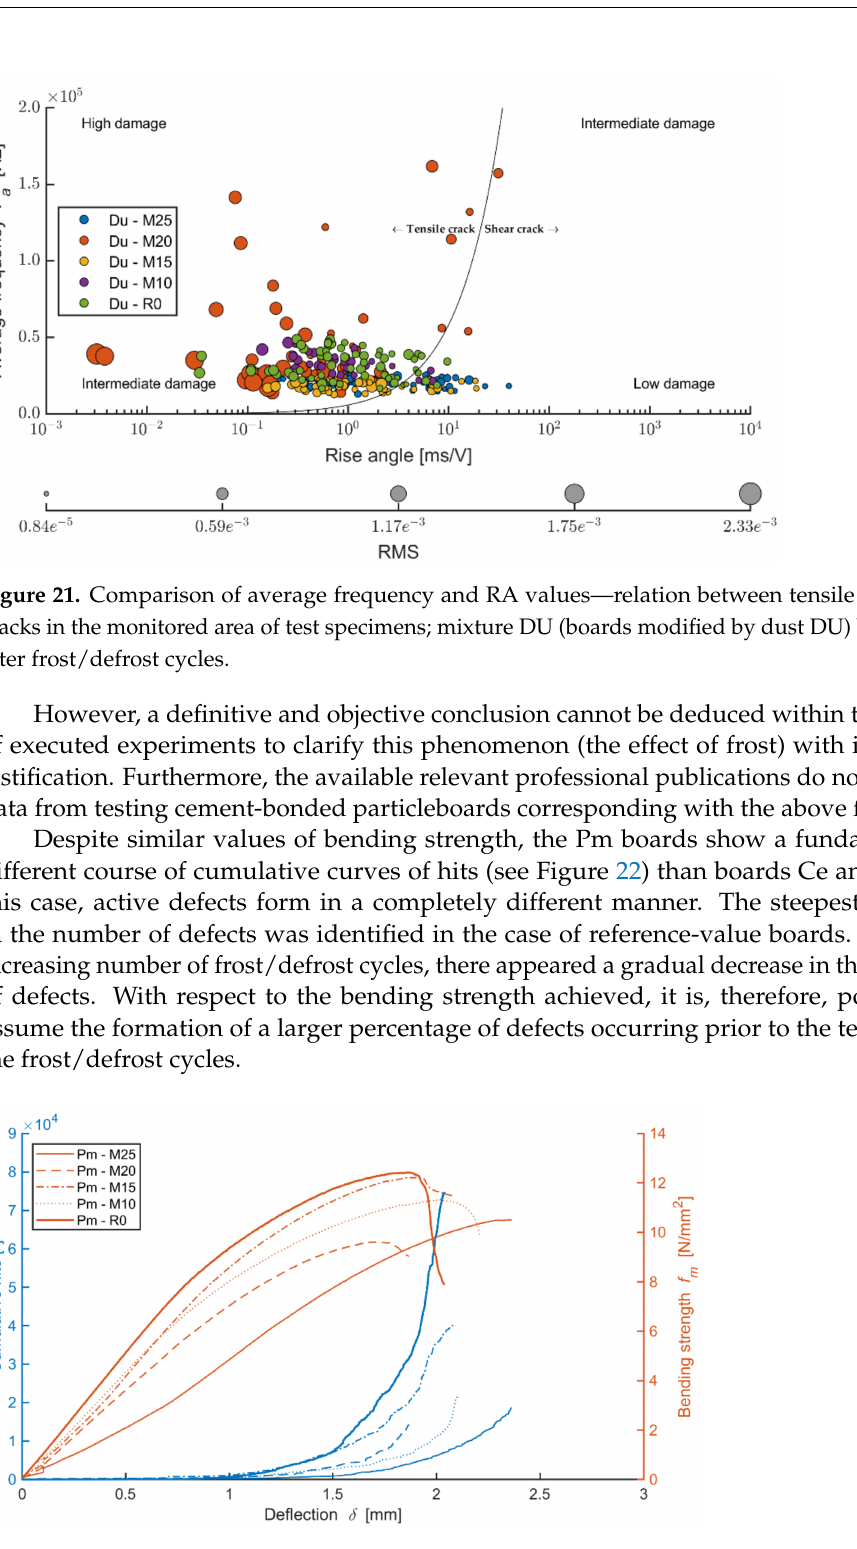
Figure 22. Comparison of bending strength, deflection and cumulative hits of representative test specimens (during mechanical load) of mixture PM (boards modified by particle mixture PM) before and after frost/defrost